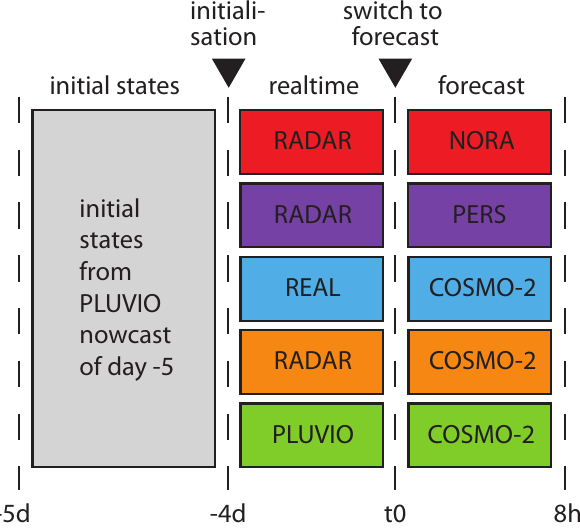
Fig. 4. Diagram showing the different forecasting chains. From the top: NORA, PERS, REAL-C2, RAD-C2 and